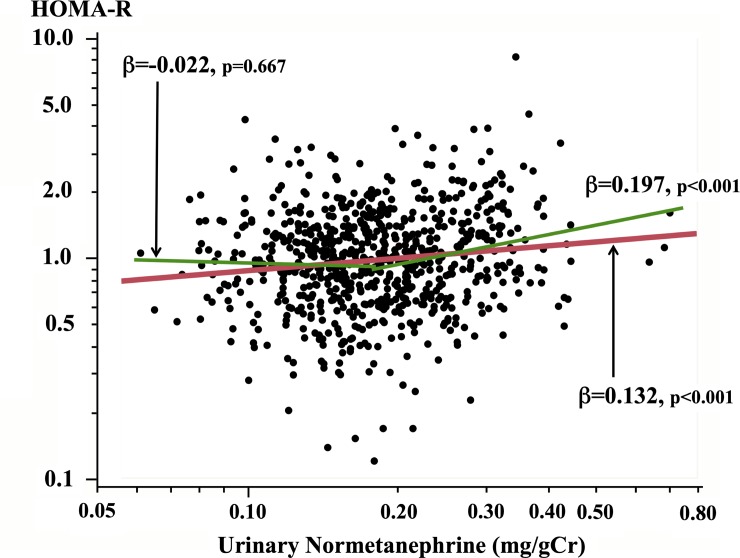
Correlation between urinary normetanephrine concentration and insulin resistance, assessed using the homeostasis model (HOMA-R).Linear regression lines are shown for the entire cohort (red line) and halves of the cohort, divided on the basis of their urinary normetanephrine concentration (upper: > 0.18 mg/g creatinine; lower: < 0.18 mg/g creatinine) (green line).